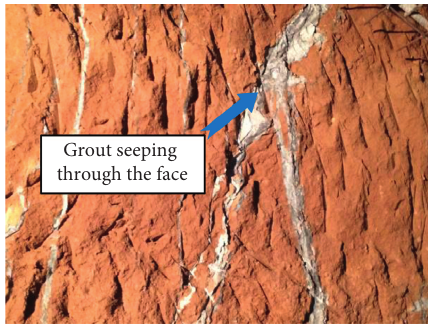
Figure 9: Grouting effect.